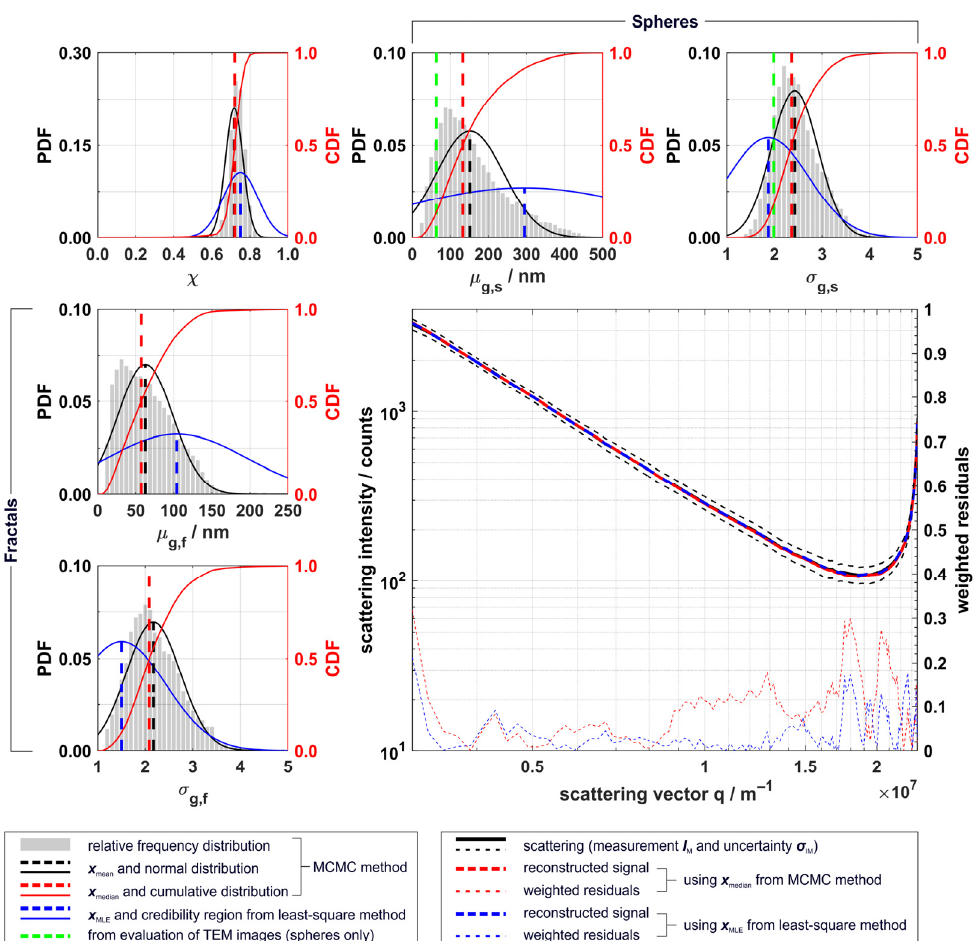
Figure 6. Top row and left column: Results for distribution parameters of spheres, fractals, and scattering intensity ratio from MCMC and least-square methods for particle scattering from an EtOH/TTIP spray flame at 120 mm HAB. Each of these diagrams shows the relative probability distributions (PDF) from the MCMC method (grey bars), its arithmetic mean x mean and normal distribution fit (black), its median x median and relative cumulative distribution (CDF, red), and the x MLE within its credibility region, derived from least-square method (blue); results from TEM image analysis for spherical particles are shown in green. Bottom, right: measured data I M (black) within the uncertainty of the measurement σ IM (black dashed lines) and the reconstructed scattering data using Equation (3) and x median of the MCMC distribution (red) and x MLE of the least-square method (blue); σ IM -weighted residuals for both reconstructions are shown in respective colors on the right y -axis. Table 1. Distribution Parameters for Spherical and Fractal Nanoparticle Fractions and their Scattering Ratio Derived from Scattering Experiments at 50 mm, 80 mm, and 120 mm HAB, Utilizing the MCMC Method (values in normal font: QoI based on x median ; values in italics: QoI based on x mean and their standard deviation); Data from TEM Analysis at 120 mm HAB Represent μ g and σ g from a Log-Normal Fit (spheres only).